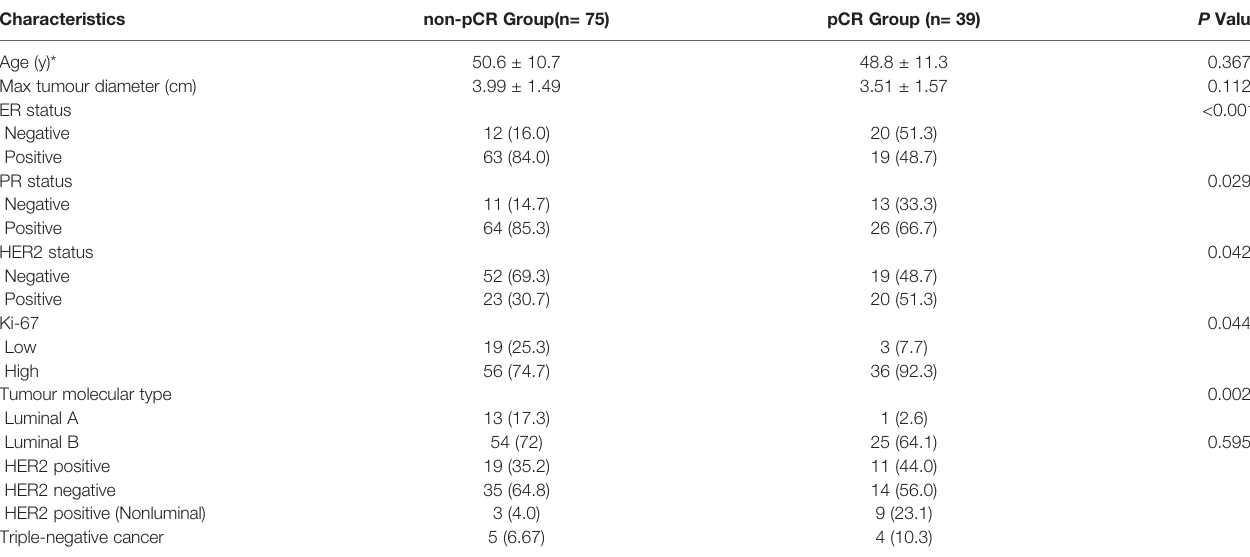
TABLE 2 | Clinical characteristics of pCR and non-pCR breast cancer patients.